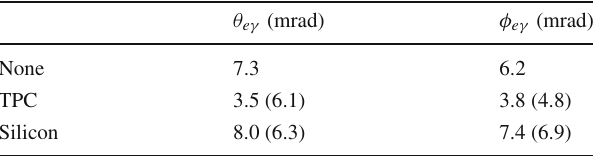
Table 8 Angular resolutions for different types of a vertex detector. A conservative estimate is given in parenthesis